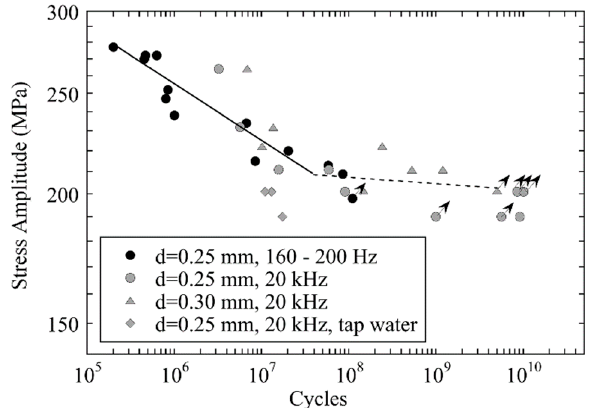
Figure 8. Fatigue data of tubes made of austenitic stainless steel AISI 904L measured with rotating bending at 160 Hz–200 Hz and ultrasonic fatigue equipment at 20 kHz; adapted with permission from John Wiley and Sons [49].